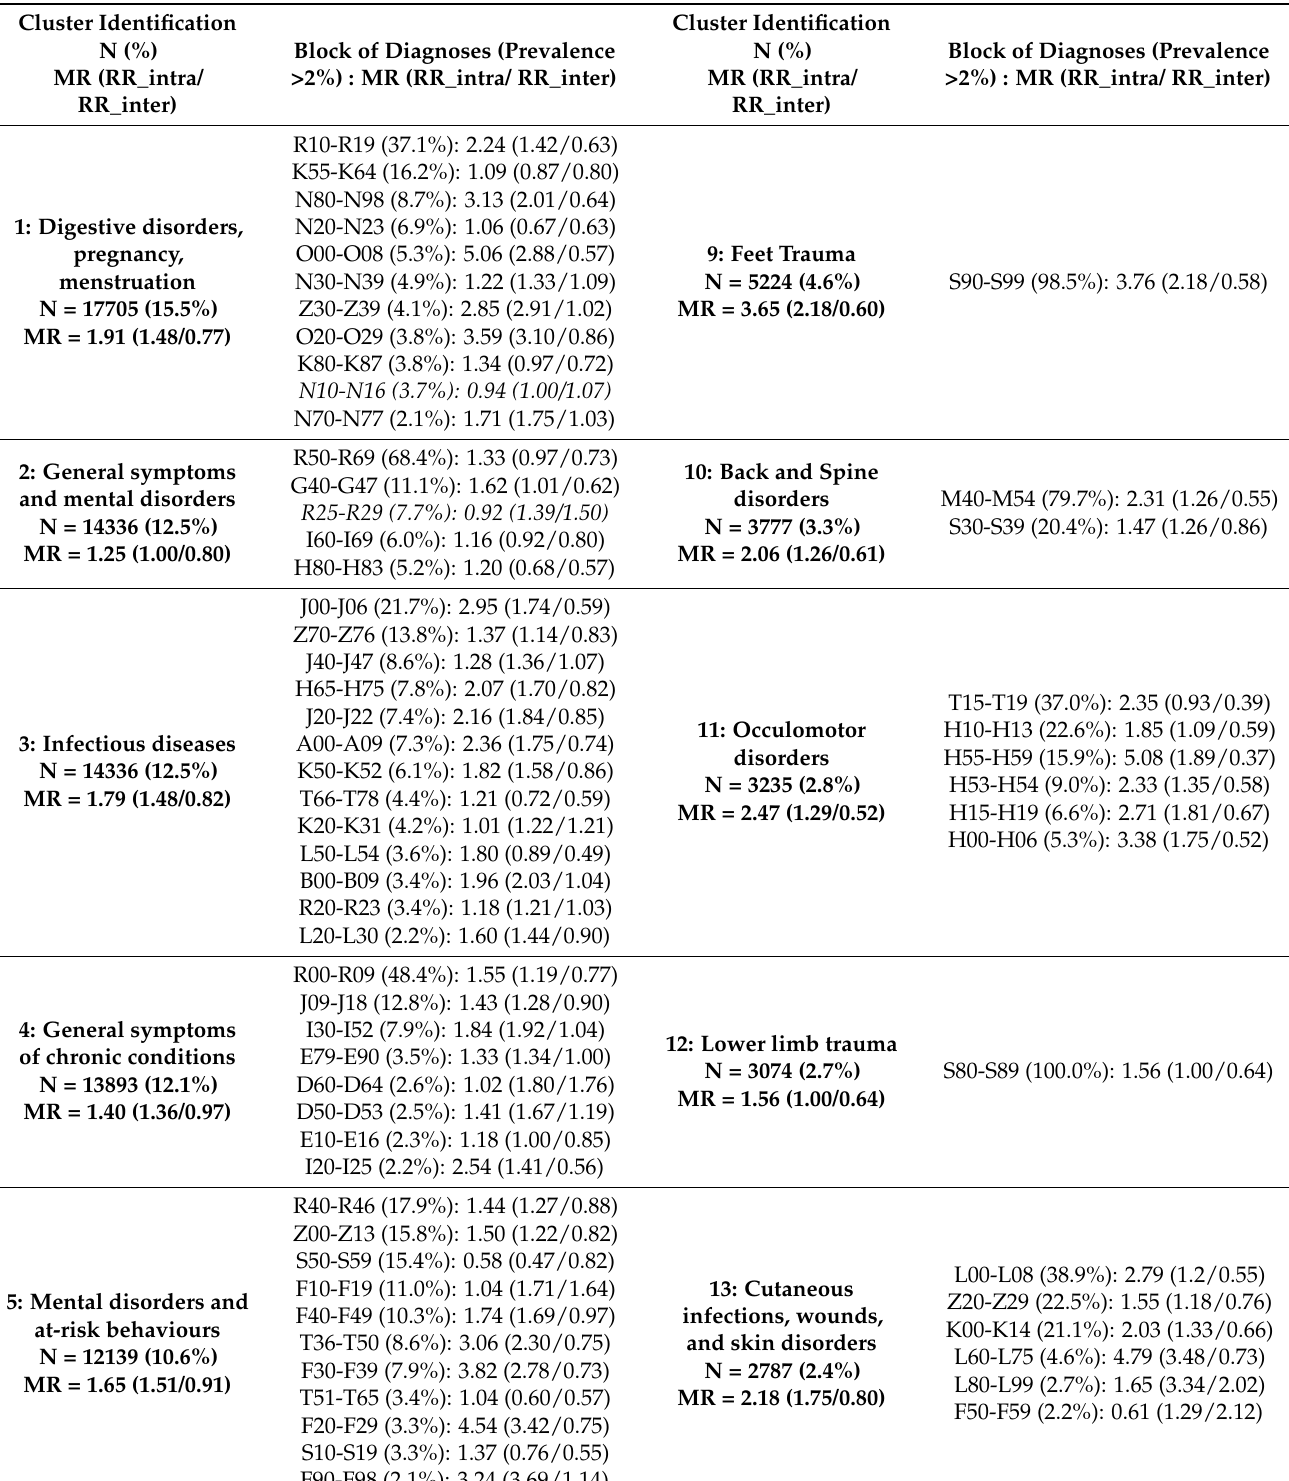
Table 2. Diagnostic content and quality indicators of the 16